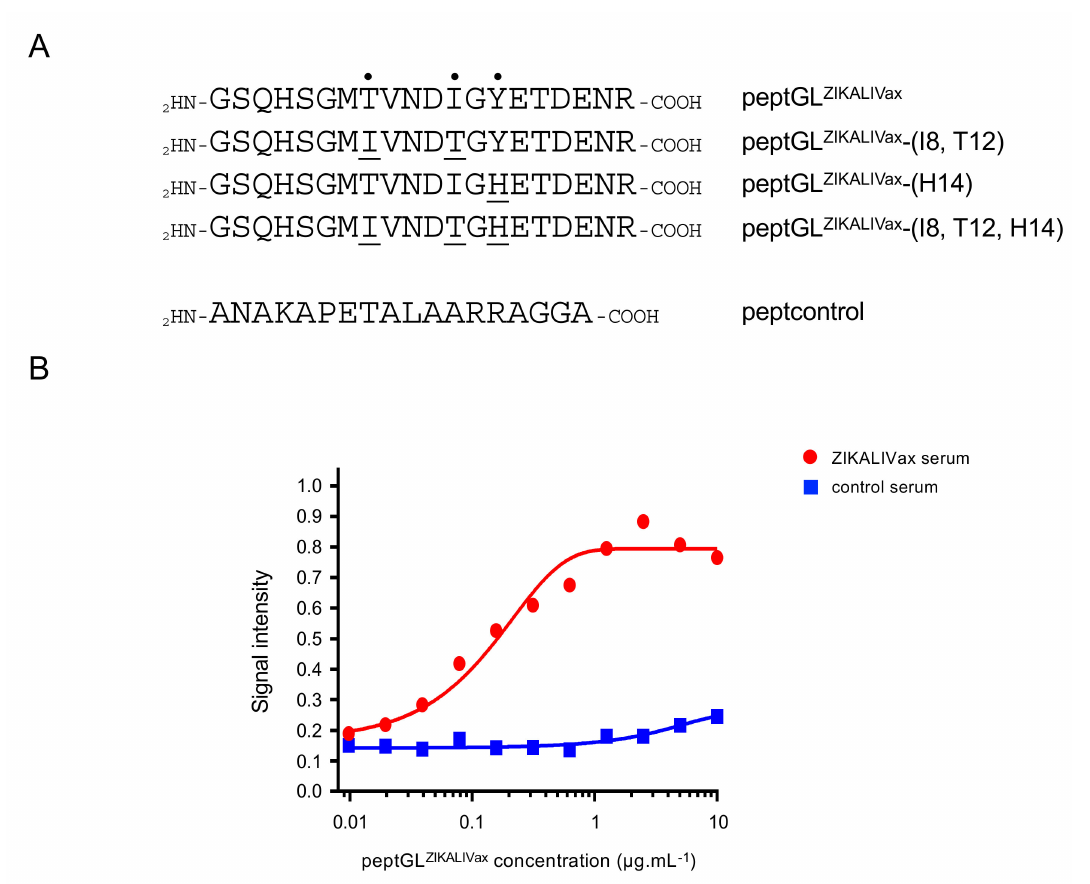
Figure 1. Reactivity of a peptide representing the ZIKALIVax glycan loop region through peptide-based ELISA. In ( A ), sequences of synthetic peptides representing the GL region from viral clone ZIKALIVax and mutants. The black points and underlined amino acids are positions that di ff er from peptGL ZIKALIVax . The irrelevant peptide peptcontrol is indicated. In ( B ), the optical density at 450 nm (O.D 450) or signal intensity of samples tested in a dose-response curve of peptGL ZIKALIVax in relation to anti-ZIKALIVax immune serum through peptide-based ELISA. Plates were coated with increasing concentrations of peptGL ZIKALIVax and incubated with a pooled anti-ZIKALIVax immune serum (ZIKALIVax serum) at dilution 1:50. A pool of serum of mice that received heat-inactivated ZIKALIVax [33] at dilution 1:50 served as a negative serum control (control